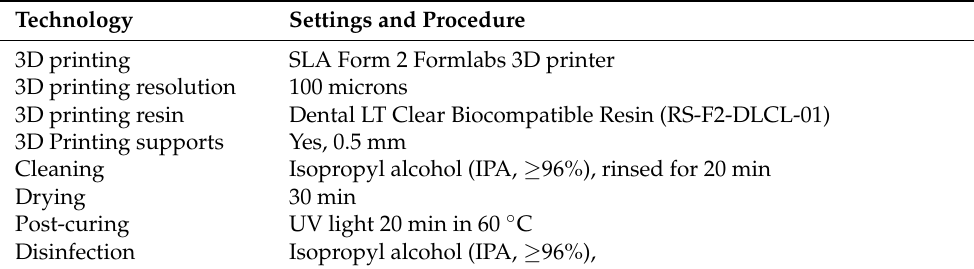
Table 2. Table of used 3D printing parameters linked with 3D printing part of the research.